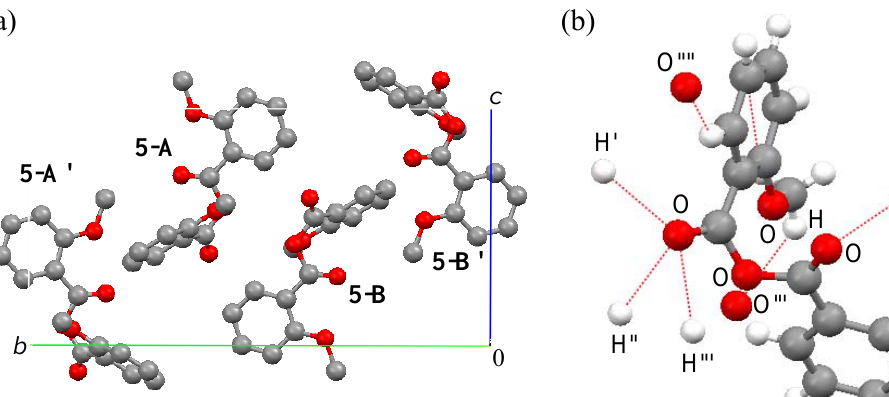
Figure 4. (a) Packing and (b) intermolecular short contacts of (2-MeOC view down to a -axis. Red, gray and white balls are oxygen, carbon and hydrogen atoms, respectively. For (a), hydrogen atoms are omitted for clarity and molecules 5-A , 5-A' , 5-B and 5-B' are enantiomorphic with each other. For (b), red dotted lines show intermolecular short